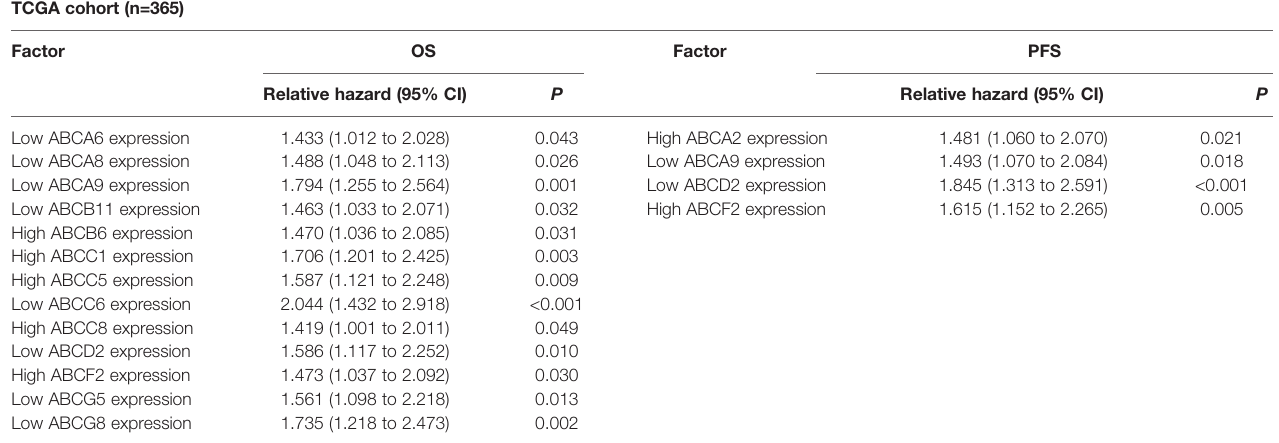
TABLE 2 | Cox regression analysis of ABC family genes in TCGA